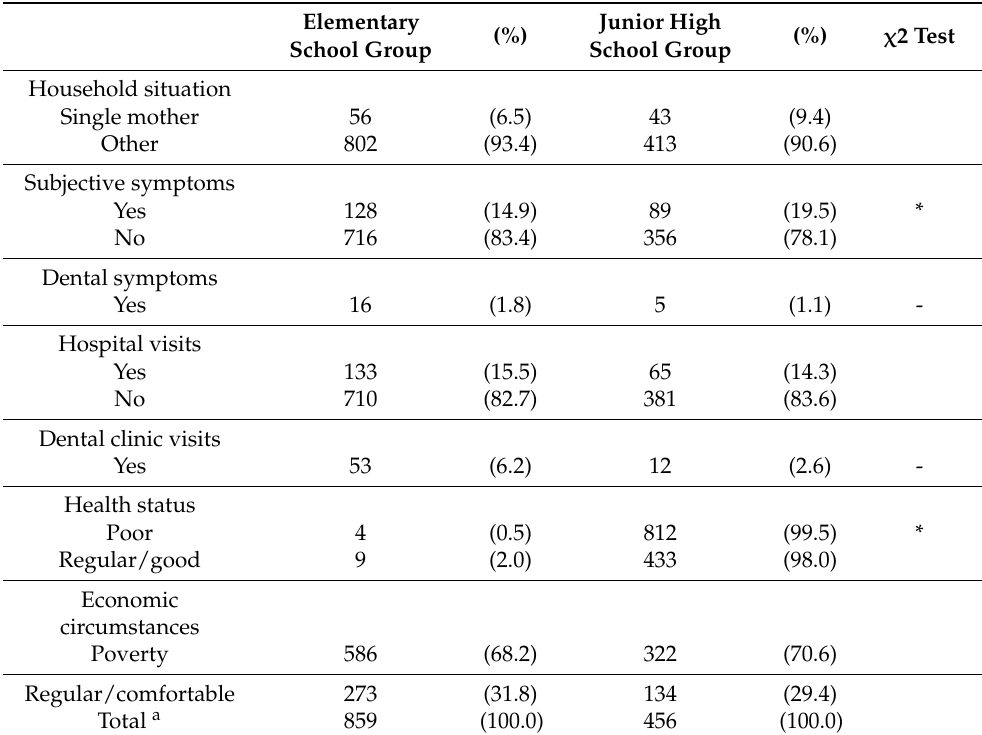
Table 2. Proportions of responses by characteristics.